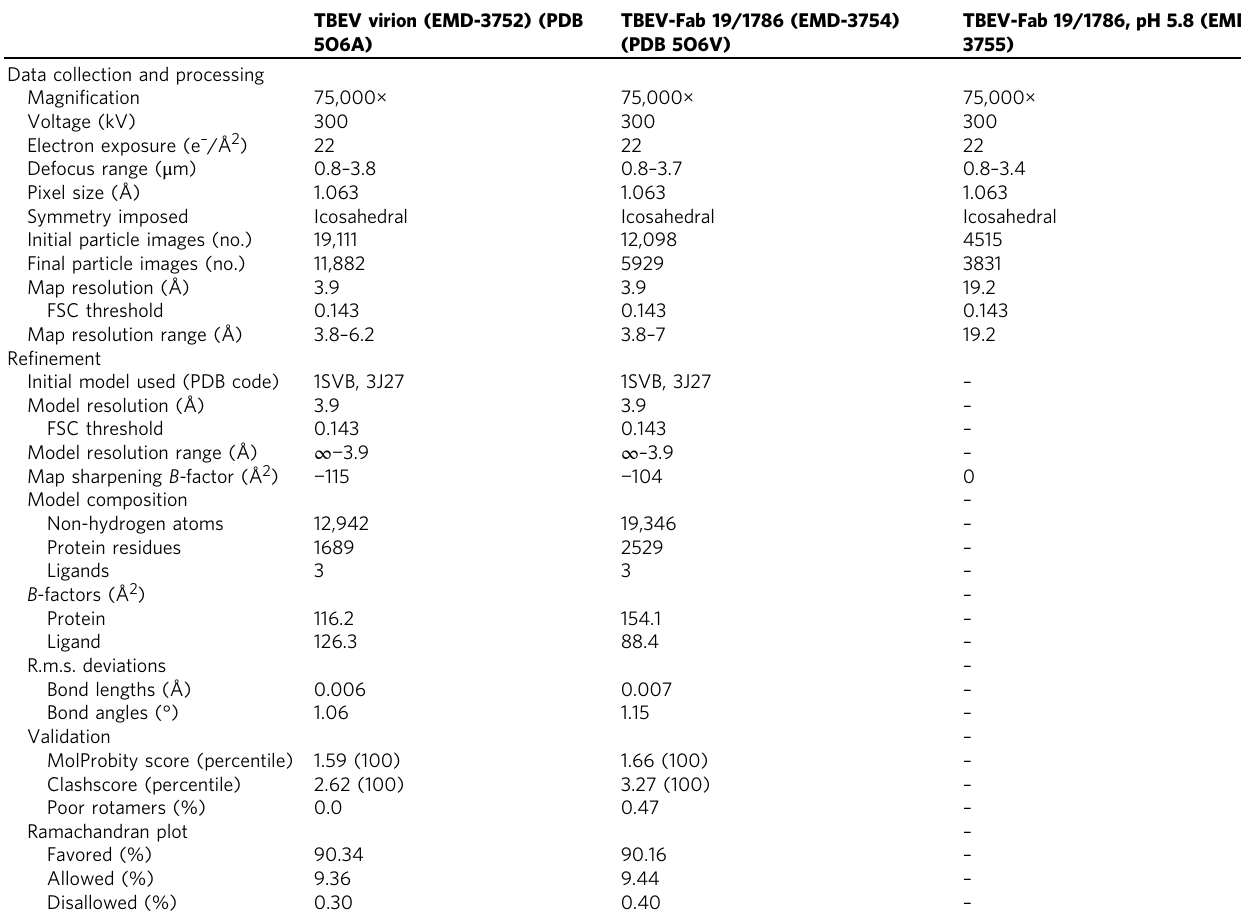
Table1 Cryo-EM data collection, re fi nement, and validation